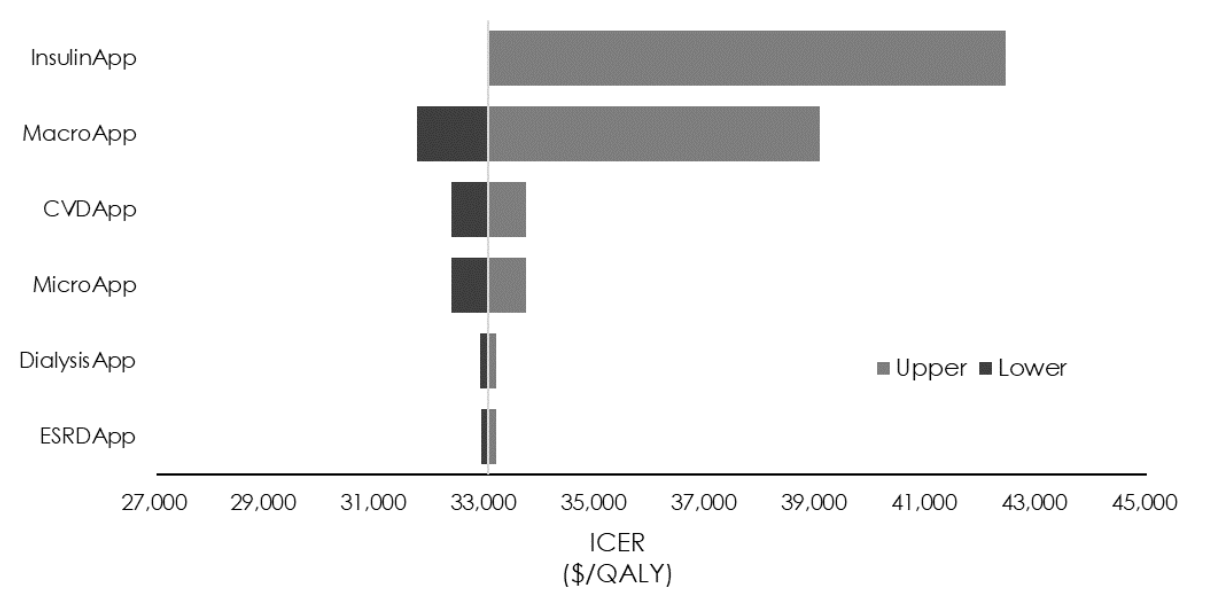
Figure 4. Sensitivity analysis of the incremental cost-effectiveness ratio (ICER) using medical fees. CVD: cardiovascular disease; ESRD: end-stage renal disease; QALY: quality-adjusted life